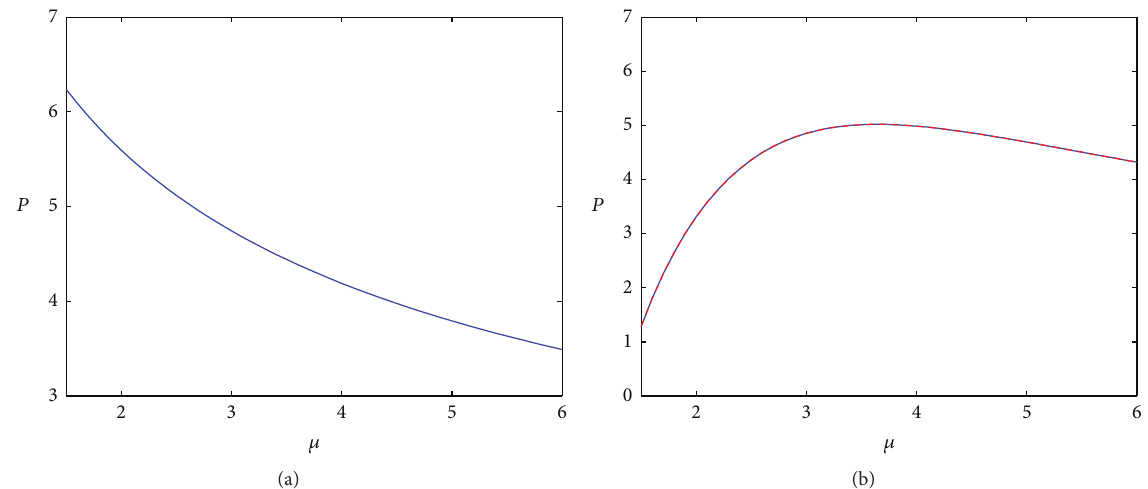
Figure 9: (a) The power of the solitons obtained by the use of the first and second renormalization factors versus 𝜇 without the optical lattice, = 0 for the self-focusing cubic and the self-focusing quintic model. (b) The power of the solitons obtained by the use of the first and second 𝑉 0 renormalization factors versus 𝜇 with the Penrose potential, 𝑉 0 = 3.5 for the self-focusing cubic and the self-focusing quintic